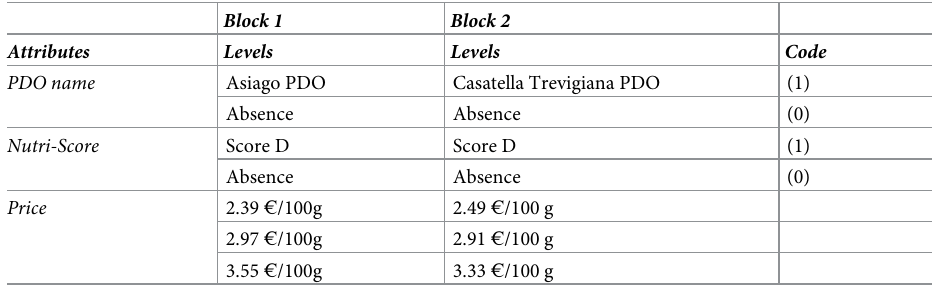
Table 2. Description of the CE attributes and